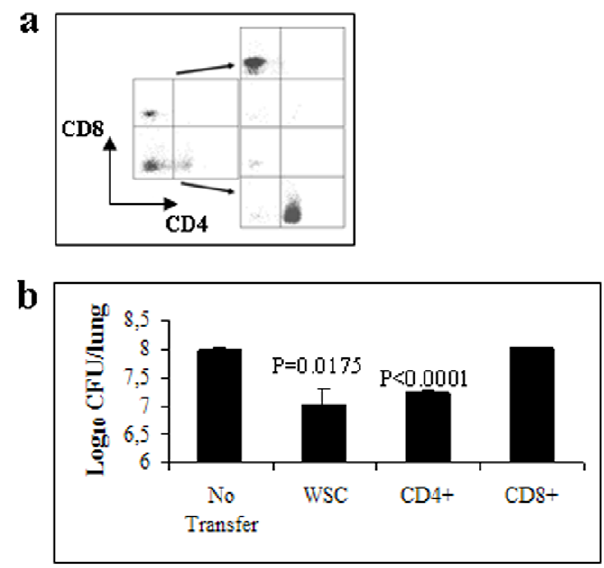
Figure 6. Protection by purified CD4 + T cells from BPZE1- immunized mice. Purified CD4 + or CD8 + T cells from BPZE1- immunized BALB/c mice ( a ) were transferred intraperitoneally to naı¨ve SCID mice 24 h before they were intranasally infected with virulent B. pertussis BPSM. The mice were sacrificed 8 days later, and CFUs present in the lungs were counted ( b ). The results are expressed as means of log CFU values per lung from 5 mice per group ( 6 standard error) and are representative of two independent experiments.